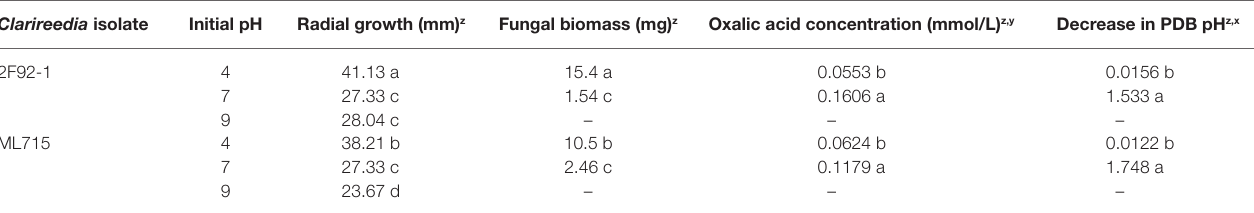
TABLE 2 | Impact on of initial pH on in vitro radial growth on potato dextrose agar (PDA) and in vitro change in biomass, OA production, and decrease in pH on potato dextrose broth (PDB) of two isolates of Clarireedia jacksonii . Clarireedia isolate